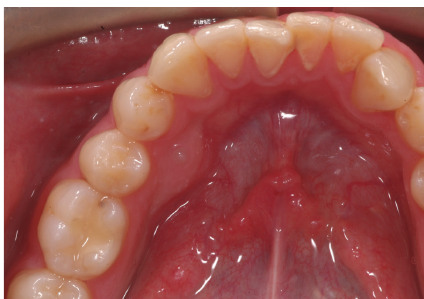
Figure 3: Case 3 intraoral image: lingual bulge in 4.4–4.5